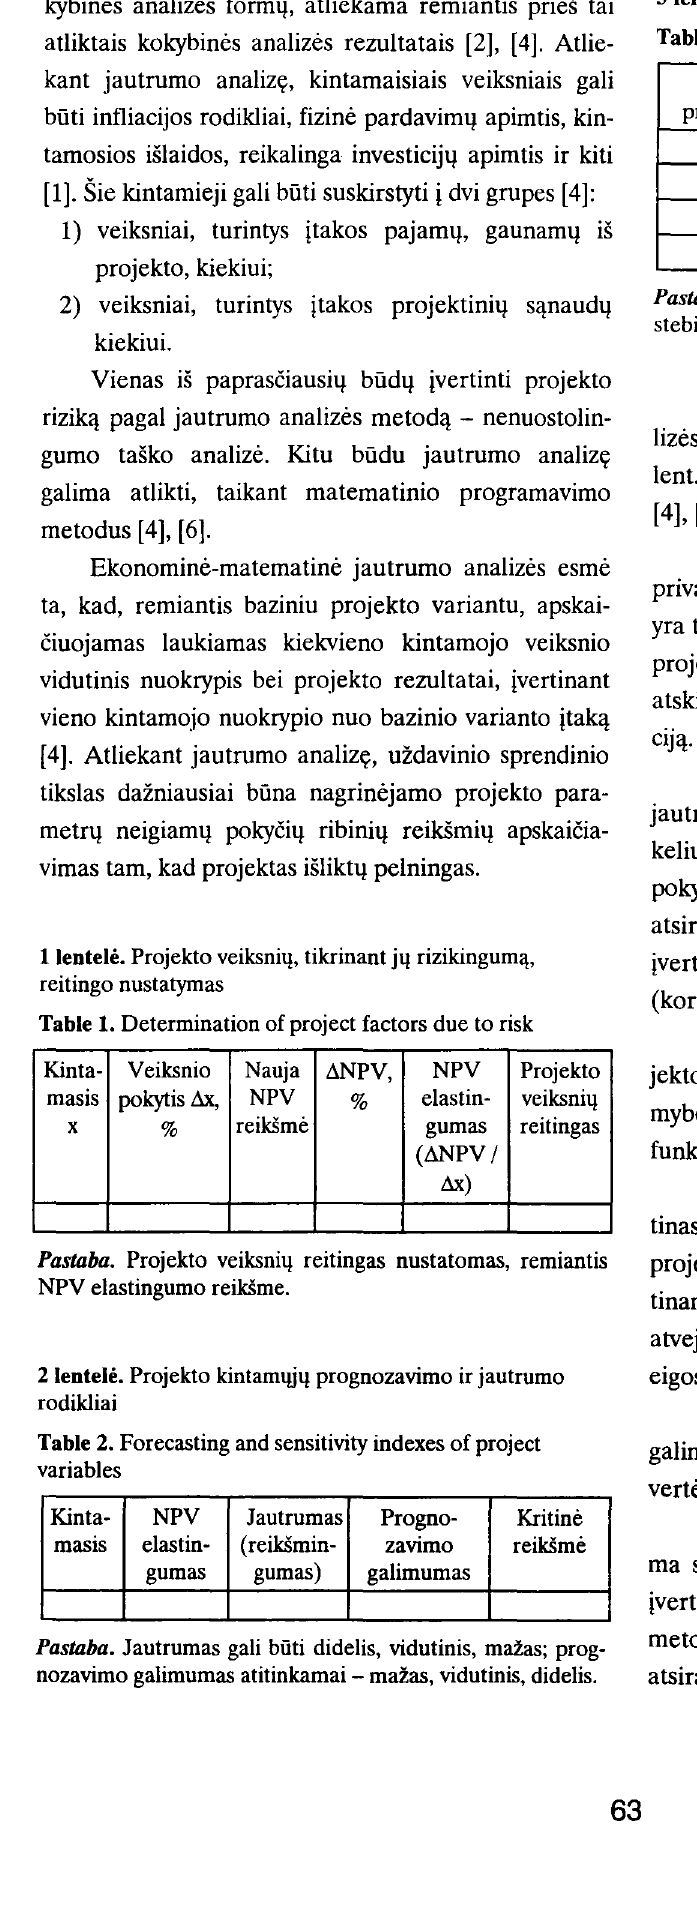
Table 3. Matrix of forecasting and sensitivity Kintamqjq Kintamojo jautrumas prognozavimas